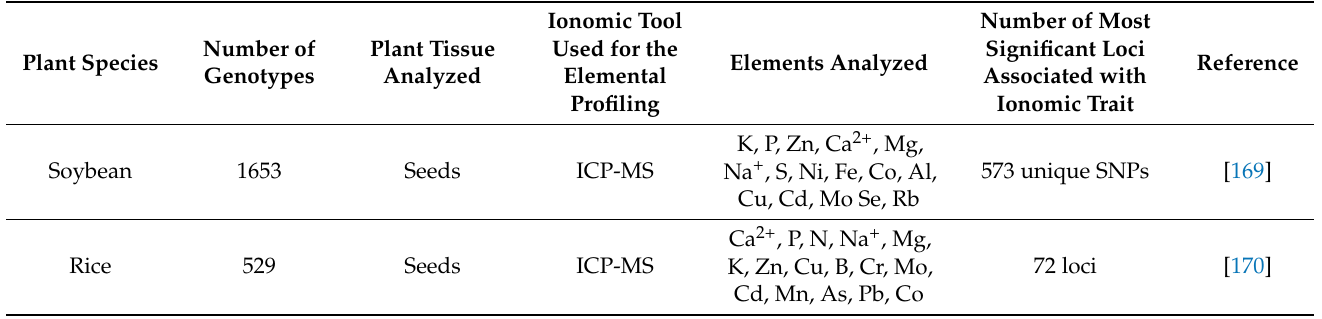
Table 3. List of different analytical platforms used in ionomics to study plant ionomes and identify loci/QTLs governing uptake and distribution of different elements in plant